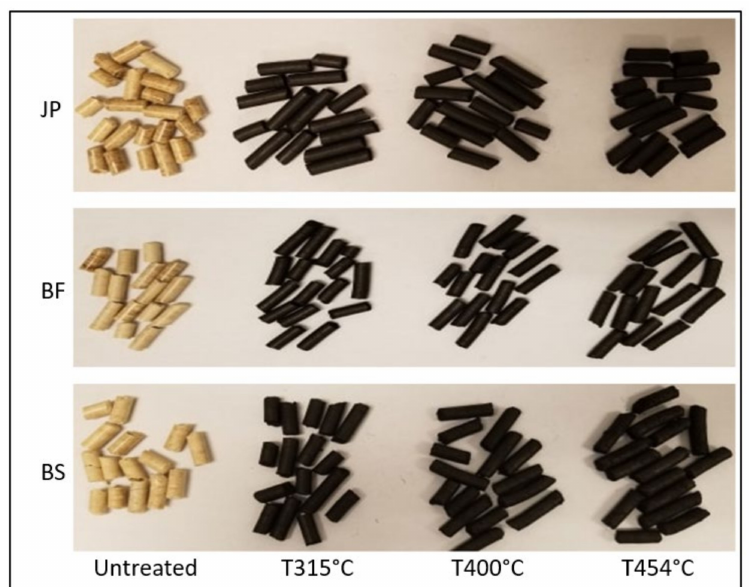
Figure 1. Images of untreated- and treated-wood pellets prepared in the present